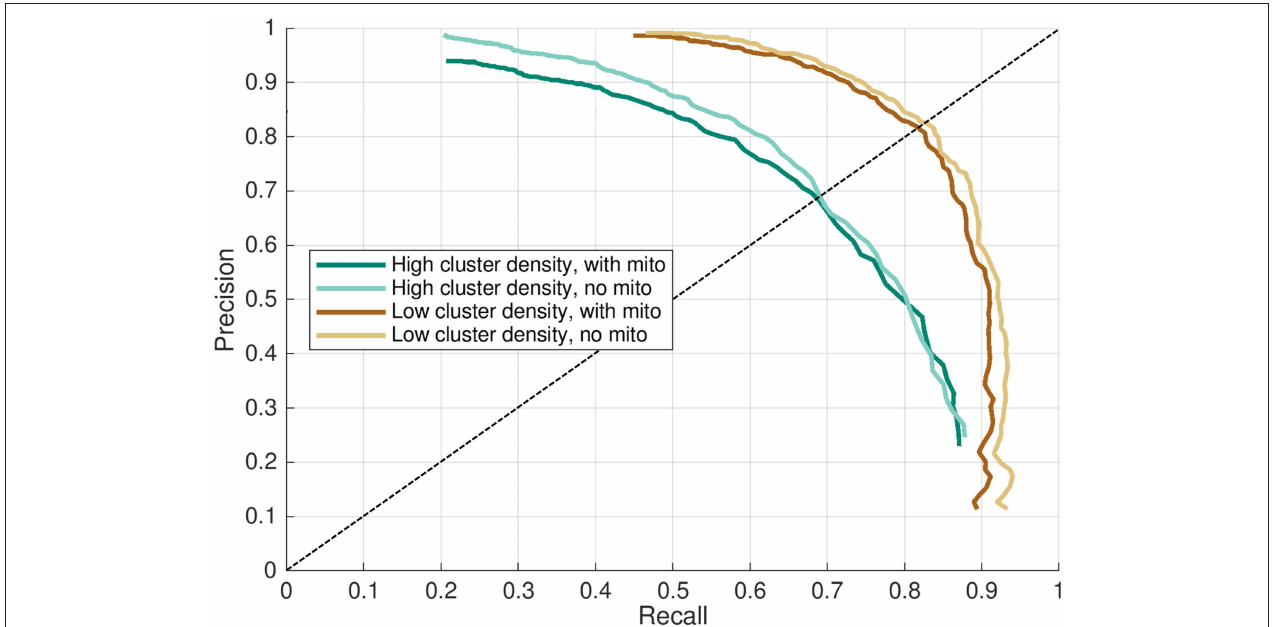
FIGURE 6 | Precision-recall curve for CaCLEAN in four models. Recall and precision mean values from results shown in Figure 5 plotted as a precision-recall curve. Higher values indicate better performance in each axis. Dashed line indicates the precision-recall break-even point, where recall =